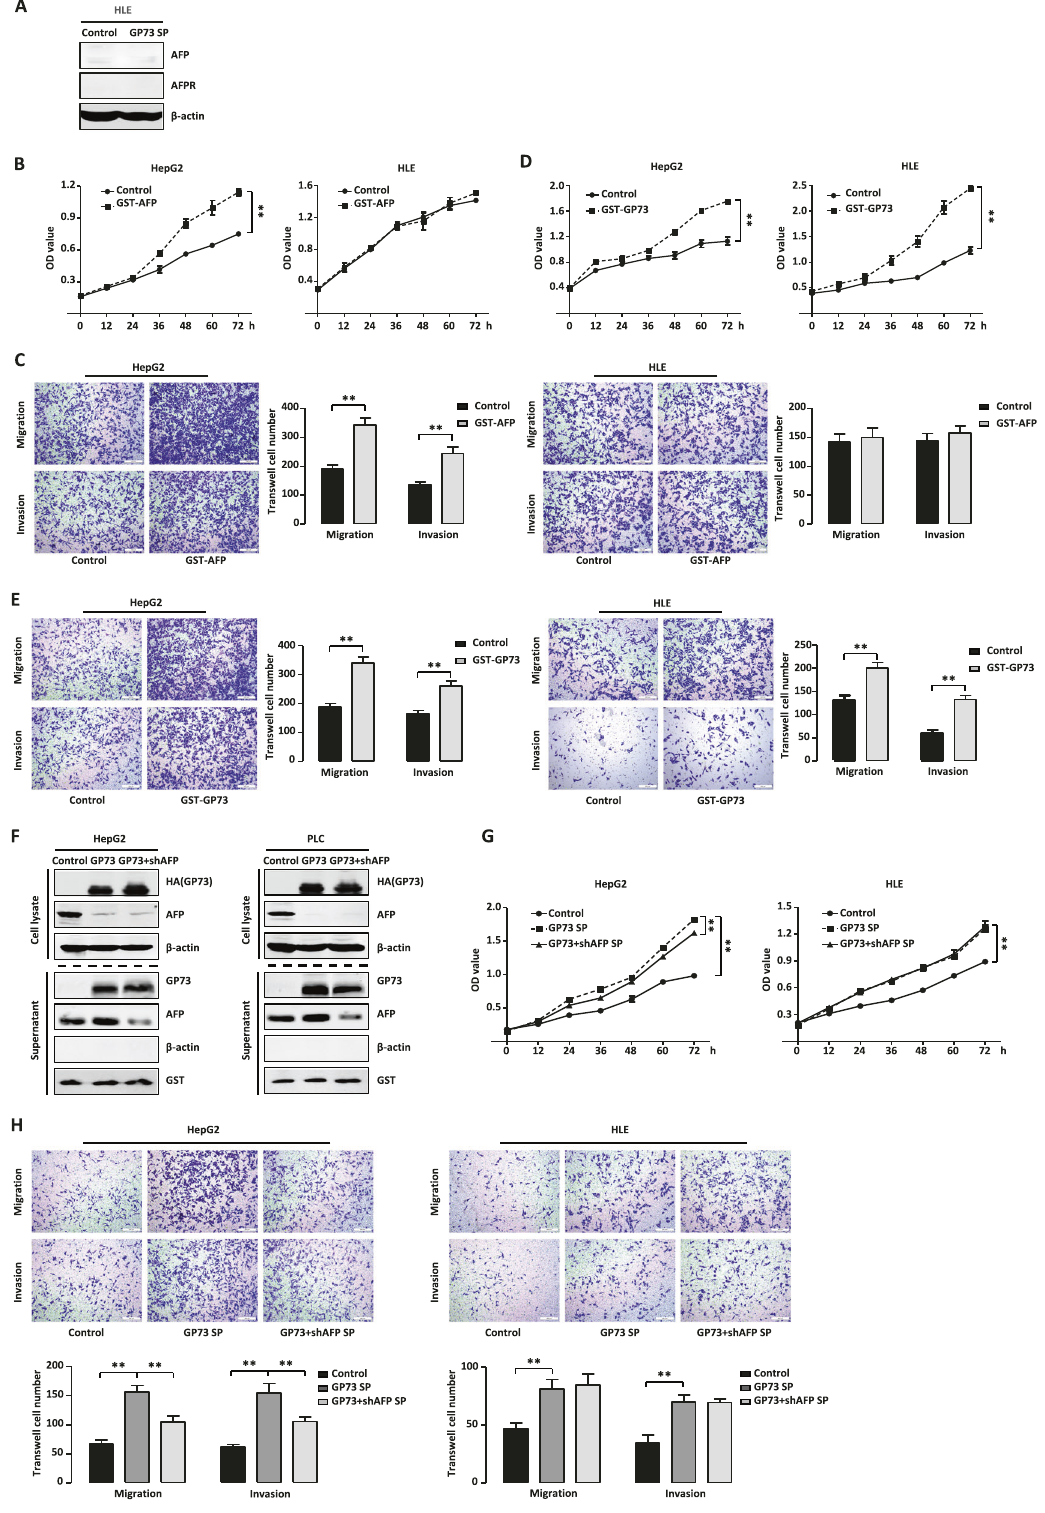
HepG2 cells, and combination treatment synergized to promote tumorigenesis. Thus, these results indicate that extracellular AFP or GP73 reduced the cytotoxic effects of sorafenib, and when combined, HCC cells became more resistant to